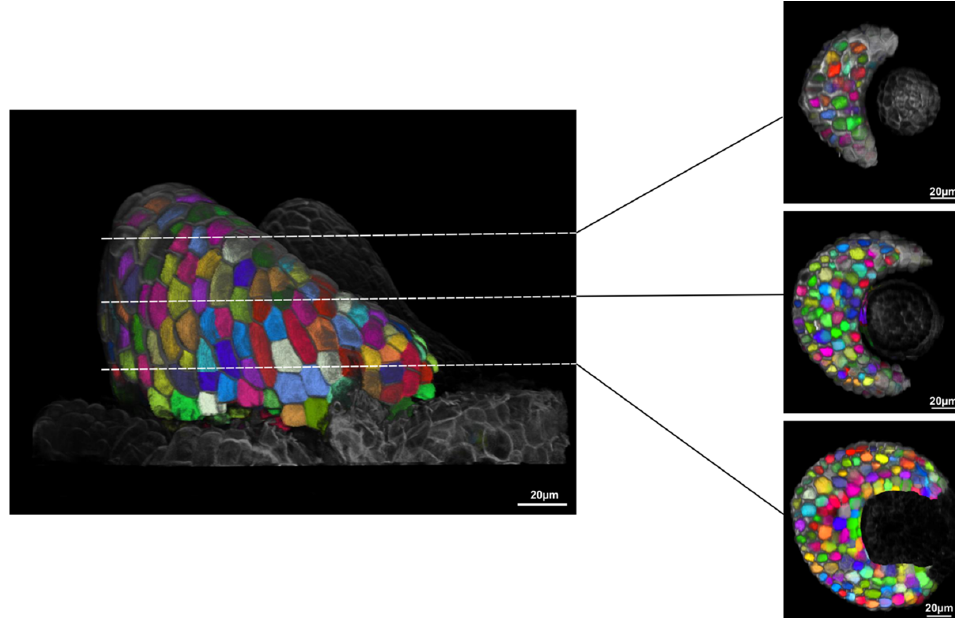
Figure 3. Example of 3D segmentation after sample stitching. Visualisation of 3D segmentation of the Plastochron 1 rice leaf primordium from Figure 2 performed using the ITK watershed autoseeded process in MorphoGraphX. Planes were virtually clipped to visualize the segmentation of the inner tissues. Scale bars: 20 μ m.